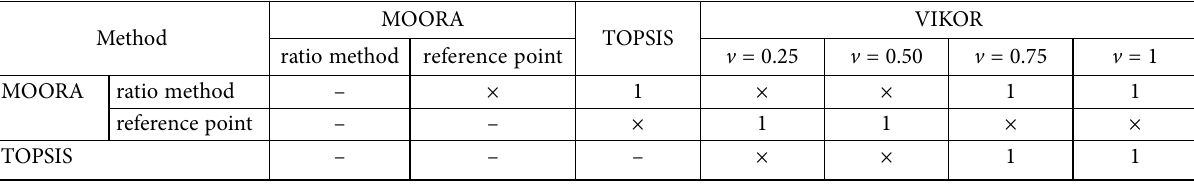
Table 8. Spearman’s rank correlation coefficient for